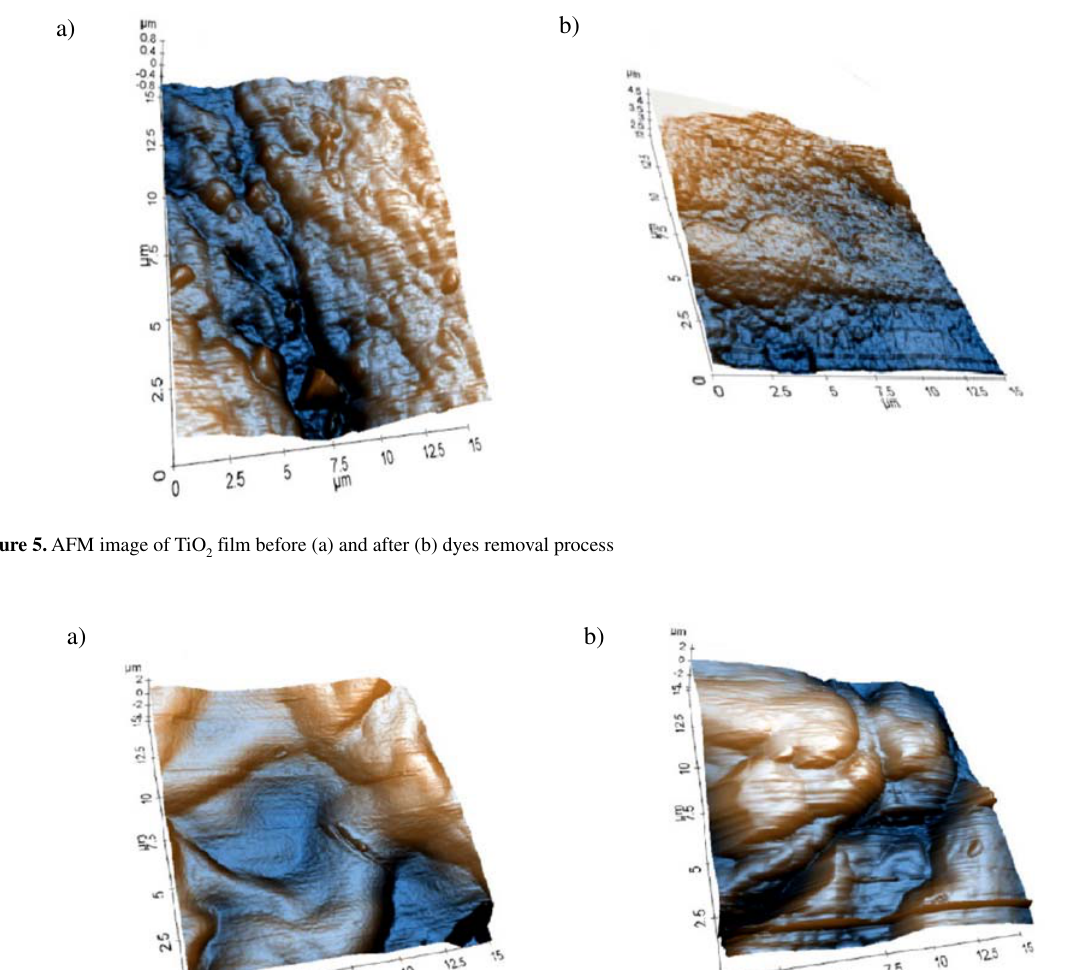
Figure 6. AFM image of corn cob film before (a) and after (b) dyes removal process